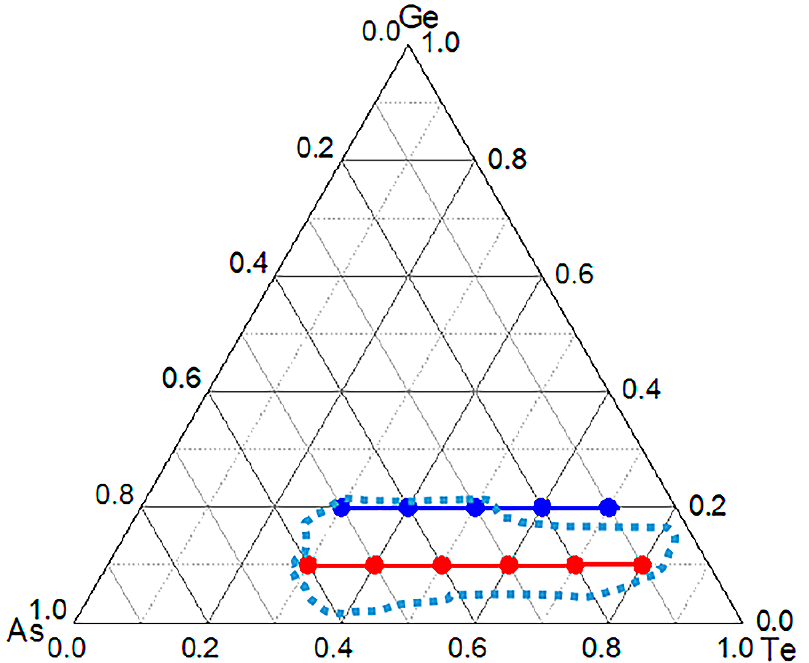
Figure 1. Glass-forming region of the Ge-As-Te glasses and two lines selected in this work (red and blue points).